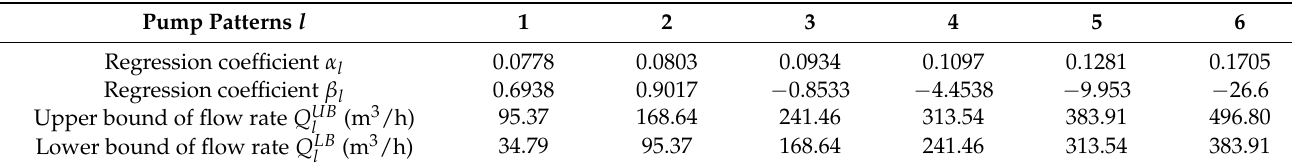
Lower bound of flow rate Q LB